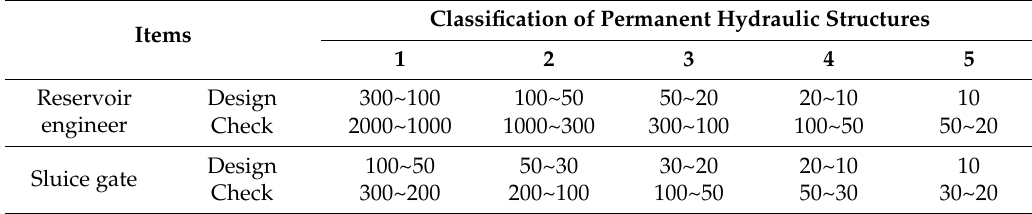
Table 4. Flood control standards for permanent hydraulic structures in plain areas, return period (year).